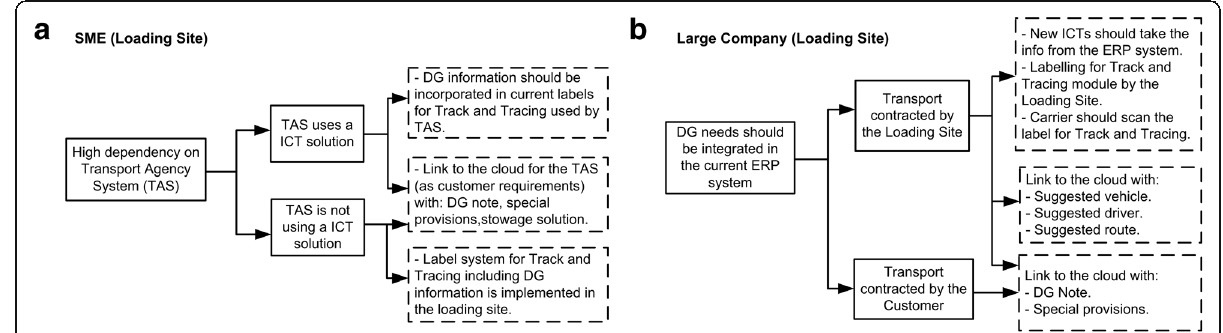
Fig. 5 Conclusions obtained during the two case studies. a ) co-creation for an SME, and b ) co-creation in a large chemical